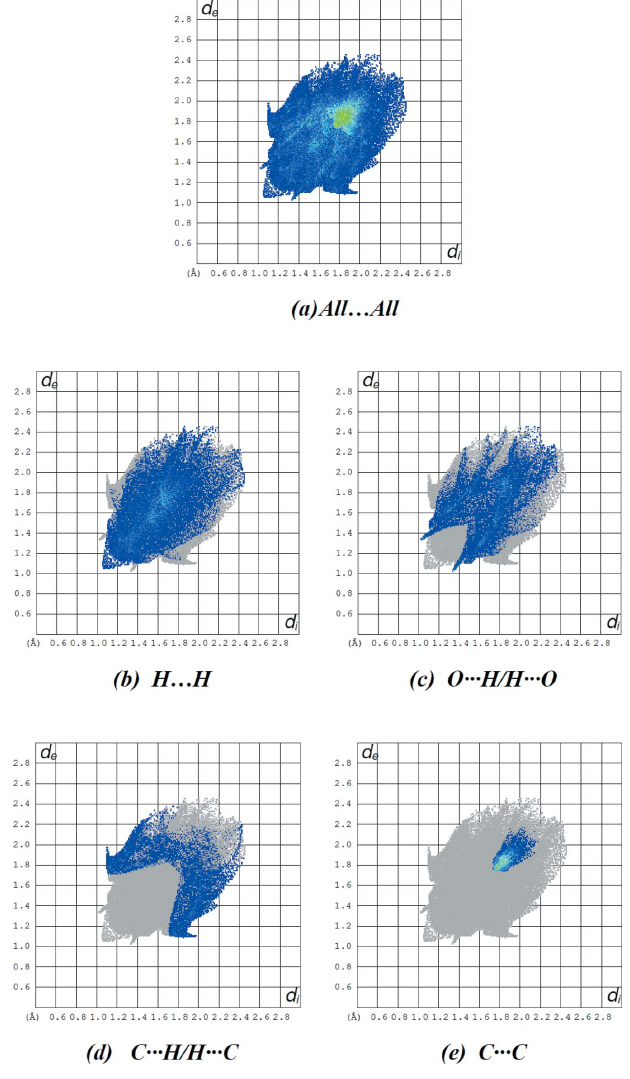
Figure 7 The full two-dimensional fingerprint plots for the title compound, showing ( a ) all interactions, and delineated into ( b ) H (cid:2)(cid:2)(cid:2) H, ( c ) O (cid:2)(cid:2)(cid:2) H/ H (cid:2)(cid:2)(cid:2) O, ( d ) C (cid:2)(cid:2)(cid:2) H/H (cid:2)(cid:2)(cid:2) C and ( e ) C (cid:2)(cid:2)(cid:2) C interactions. The d i and d e values are the closest internal and external distances (in A˚ ) from given points on the Hirshfeld surface